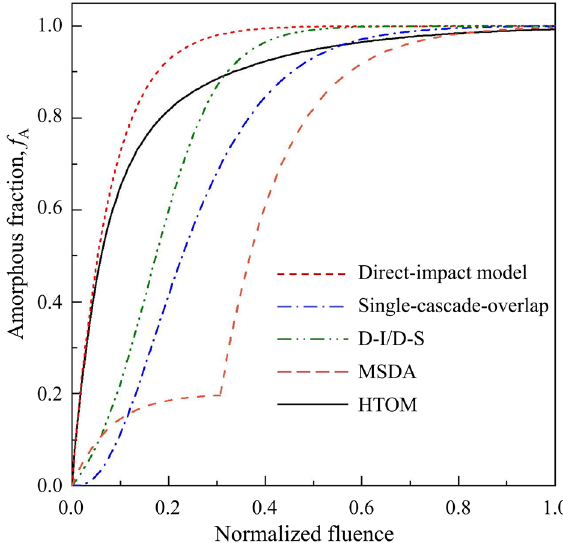
Figure 7. Amorphous fraction as a function of normalized ion fluence for direct-impact model, single-cascade-overlap, direct-impact/defect-stimulated (D-I/D-S), multiple step damage accumulation (MSDA), and heterogeneous track overlap model (HTOM). Reproduced with permission from Reference [142], Copyright © Elsevier 2012.